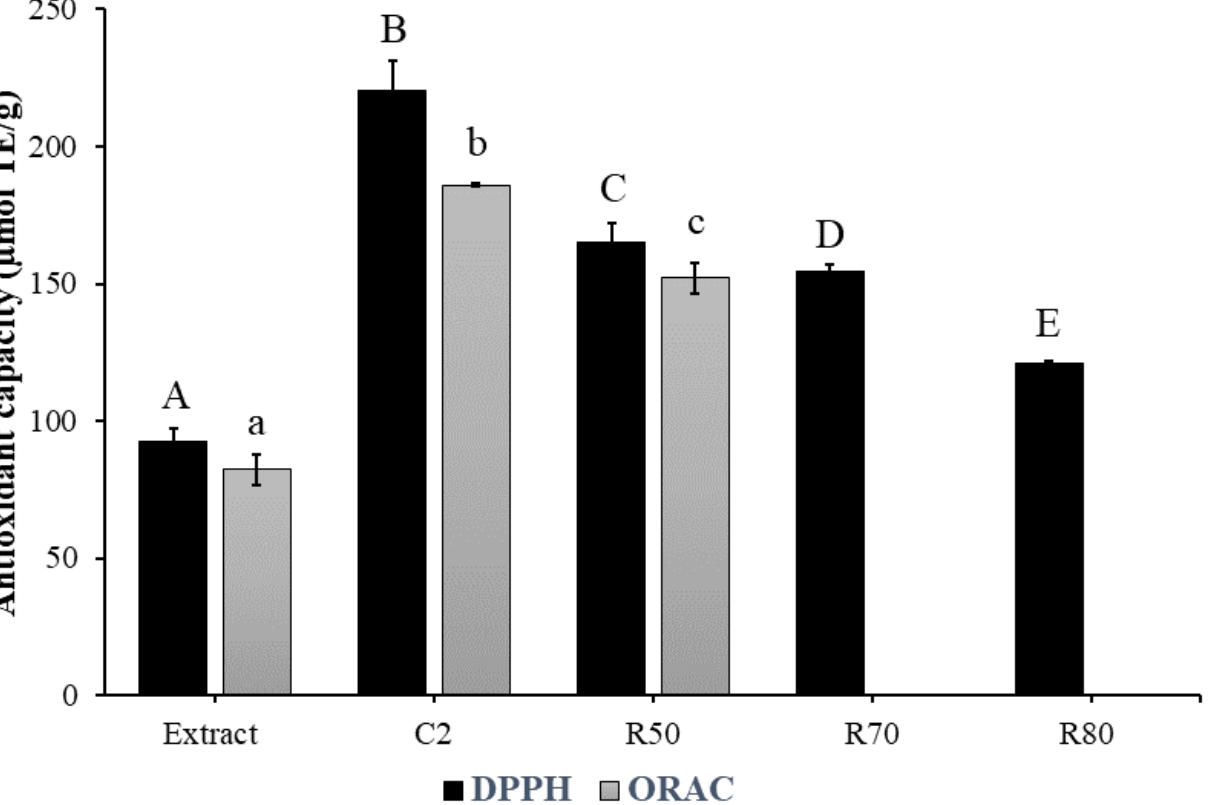
Figure 4. Antioxidant capacity by DPPH and ORAC in concentrated maqui products (cryoconcentrated and evaporated). Extract: C—cryoconcentrate; evaporation at 50 °C (R50), 70 °C (R70), and 80 °C (R80). Different capital letters over the bars indicate a significant difference ( p ≤ 0.05 for DPPH content) and different capital letters over the bars indicate a significant difference ( p ≤ 0.05 ORAC content) in concentrated maqui products (cryoconcentrated and evaporated), according to Tukey’s